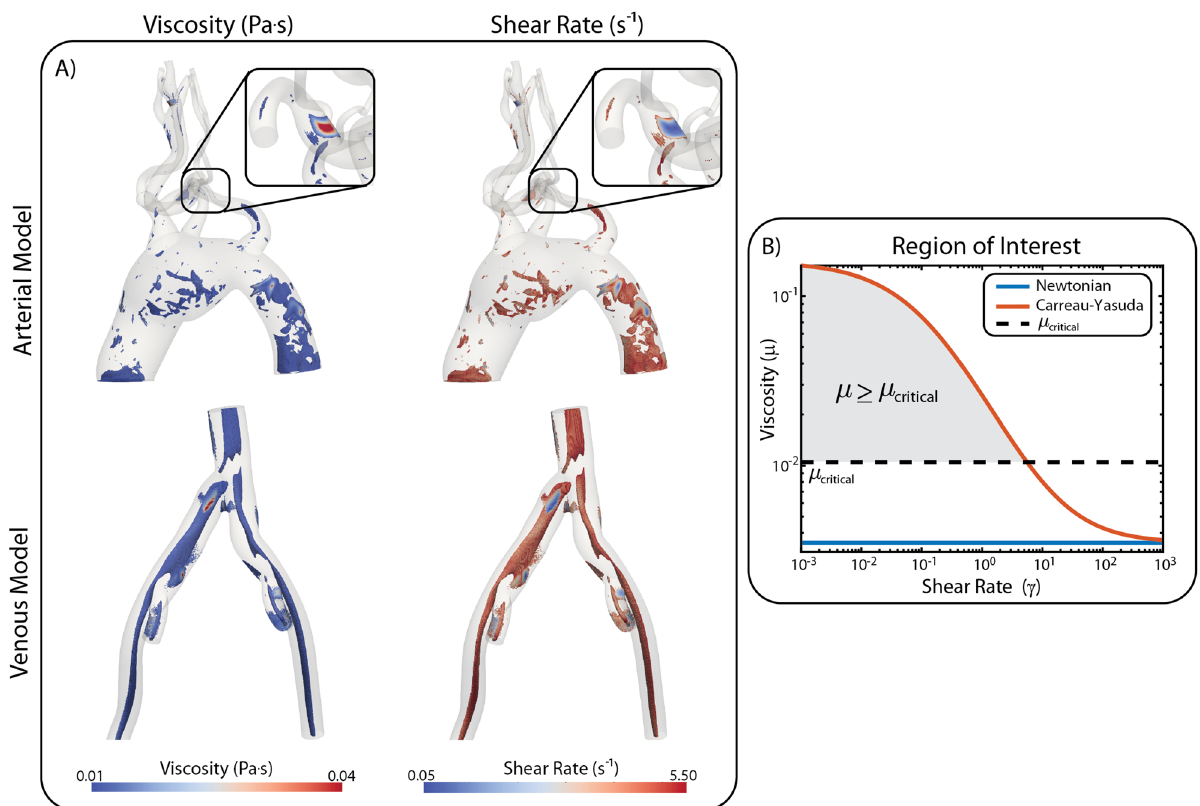
Figure 5. ( A ) Maps of viscosity and shear rate obtained with the Carreau-Yasuda model in the regions of the computational domain where the viscosity is greater than the critical threshold ( µ where the non-Newtonian effects are most important. ( B ) Critical viscosity is defined by µ critical